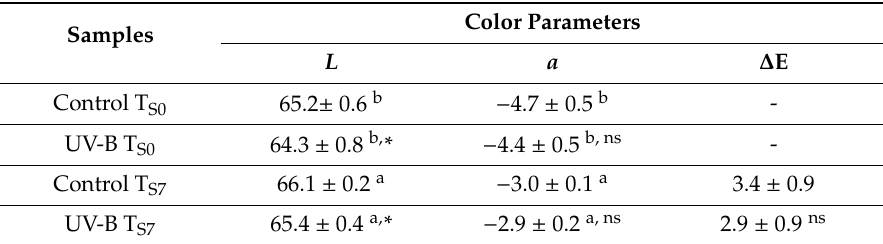
Table 4. Colorimetric parameters of O. basilicum leaves from control and supplemental UV-B light treatments before and after the storage time (at T S0 and T S7 , respectively).